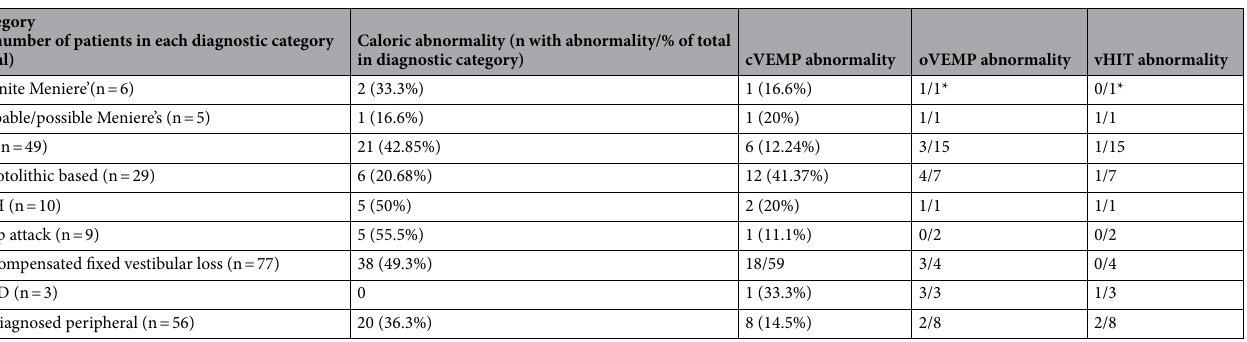
Table 6. Vestibular testing results. RV recurrent vestibulopathy, SSCD superior semicircular canal dehiscence syndrome, DEH delayed endolymphatic hydrops. Undiagnosed peripheral represented those with a history suggestive for peripheral vestibular dysfunction but defied simple classification into a recognized subgroup according to symptoms/signs/duration of vertigo etc. *The number represents the total number of patients being tested.